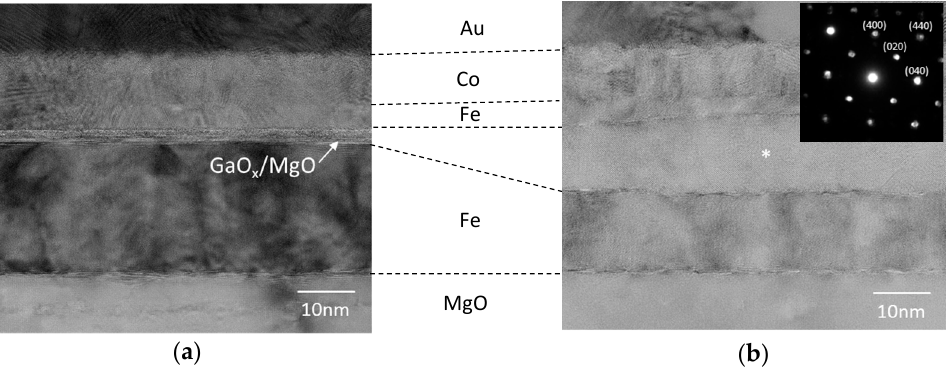
Figure 3. Cross-sectional transmission electron microscope (TEM) images of the MTJ samples ( a ) with ( b ) without the MgO underlying layer ([100] azimuth of the MgO substrate). Broken lines indicate the interfaces among the layers. The inset of Figure 3b shows electron nano-beam diffraction pattern at the point indicated by an asterisk symbol.